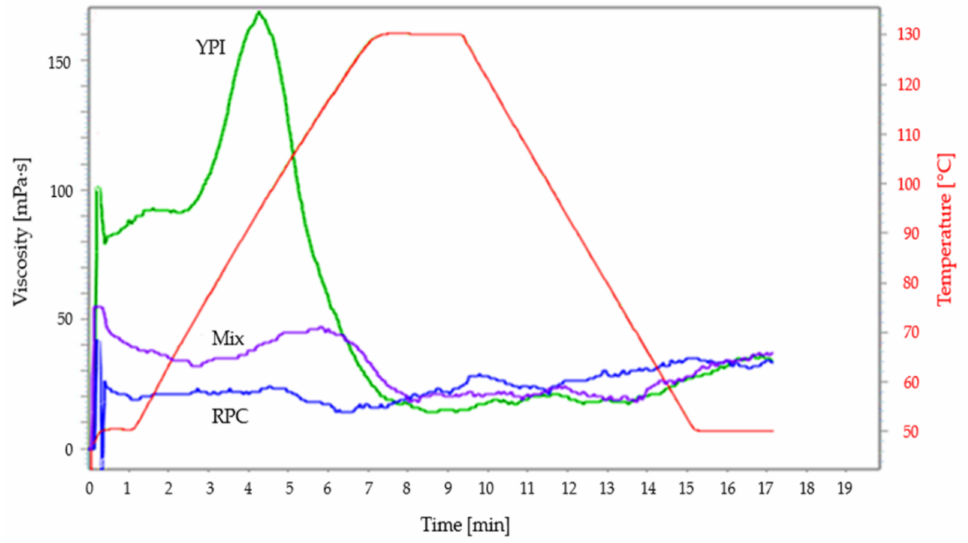
Figure 3. Pasting properties for YPI, RPC, and mixed